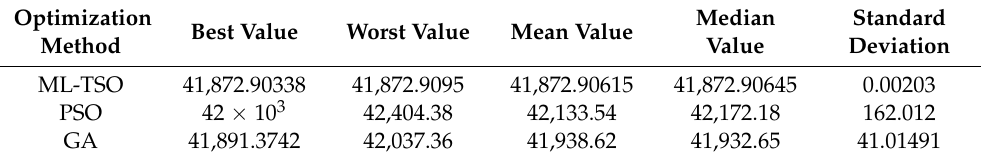
Table 8. The best, worst, mean, median, and standard deviation values in the case of the 57-bus system.